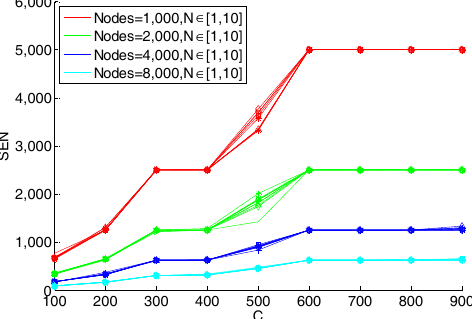
Figure 7. The average storage in each node, ( a ) N = 1, ( b ) N = 2, ( c ) N = 3, and ( d ) N = 4.